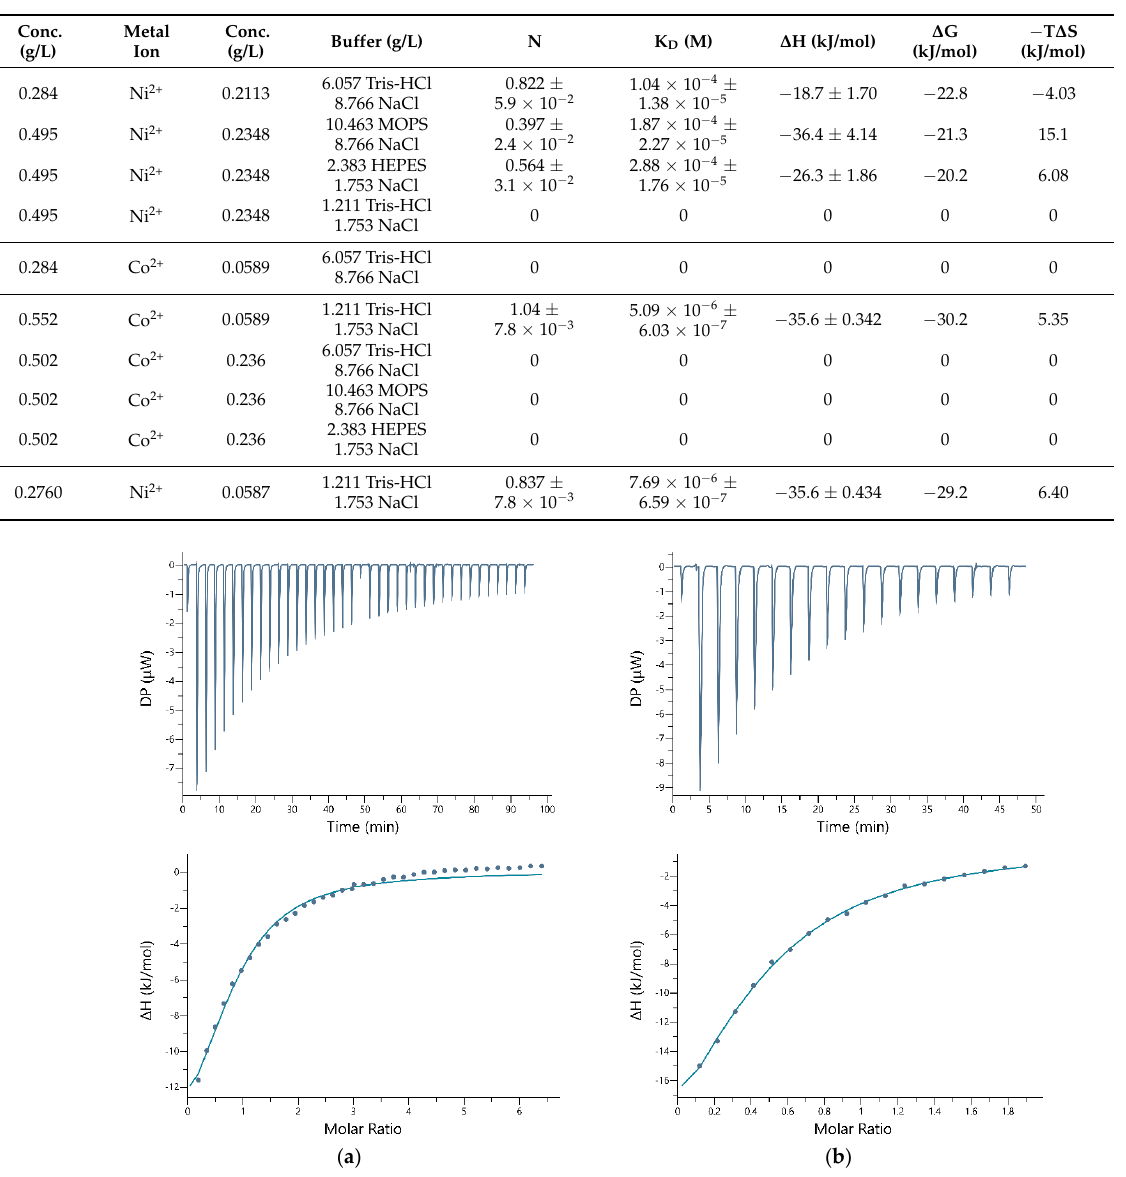
Figure 2. Isothermal titration calorimetry results of the cyclic nickel-binding peptide CNAKHHPRCGGG with Ni 2+ ions. Top: raw heat rate (µW) vs. time (min). Bottom: changes in enthalpy (kJ/mol) vs. molar ratio of the reactants. ( a ) Tris-HCl + NaCl, pH 7.4; ( b ) MOPS + NaCl, pH 7.4. The data were fitted using a one-set-of-sites model.